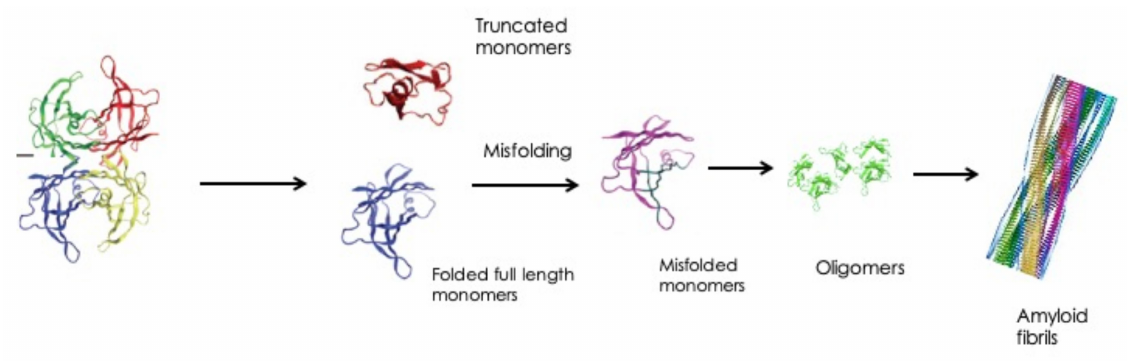
Figure 3. Biochemical mechanisms leading to amyloidosis